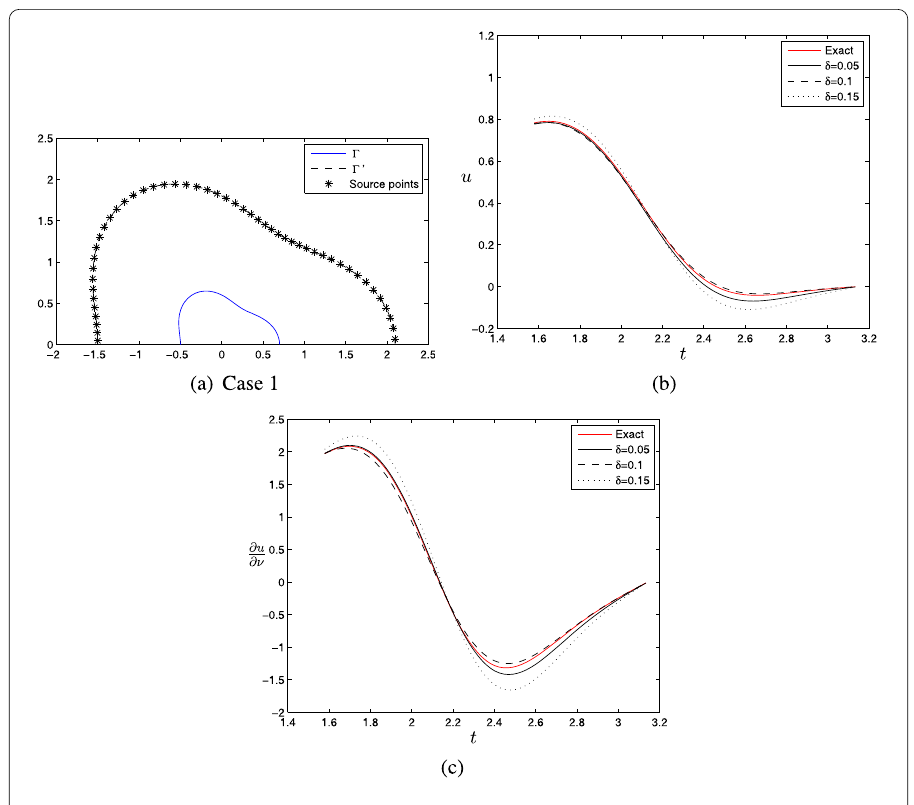
Figure 2 The exact solution and the numerical solutions on Γ 2 with δ ∈ { 0.05,0.1,0.15